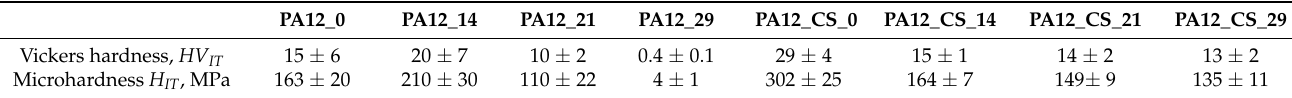
Table 8. Microhardness results of tested samples.